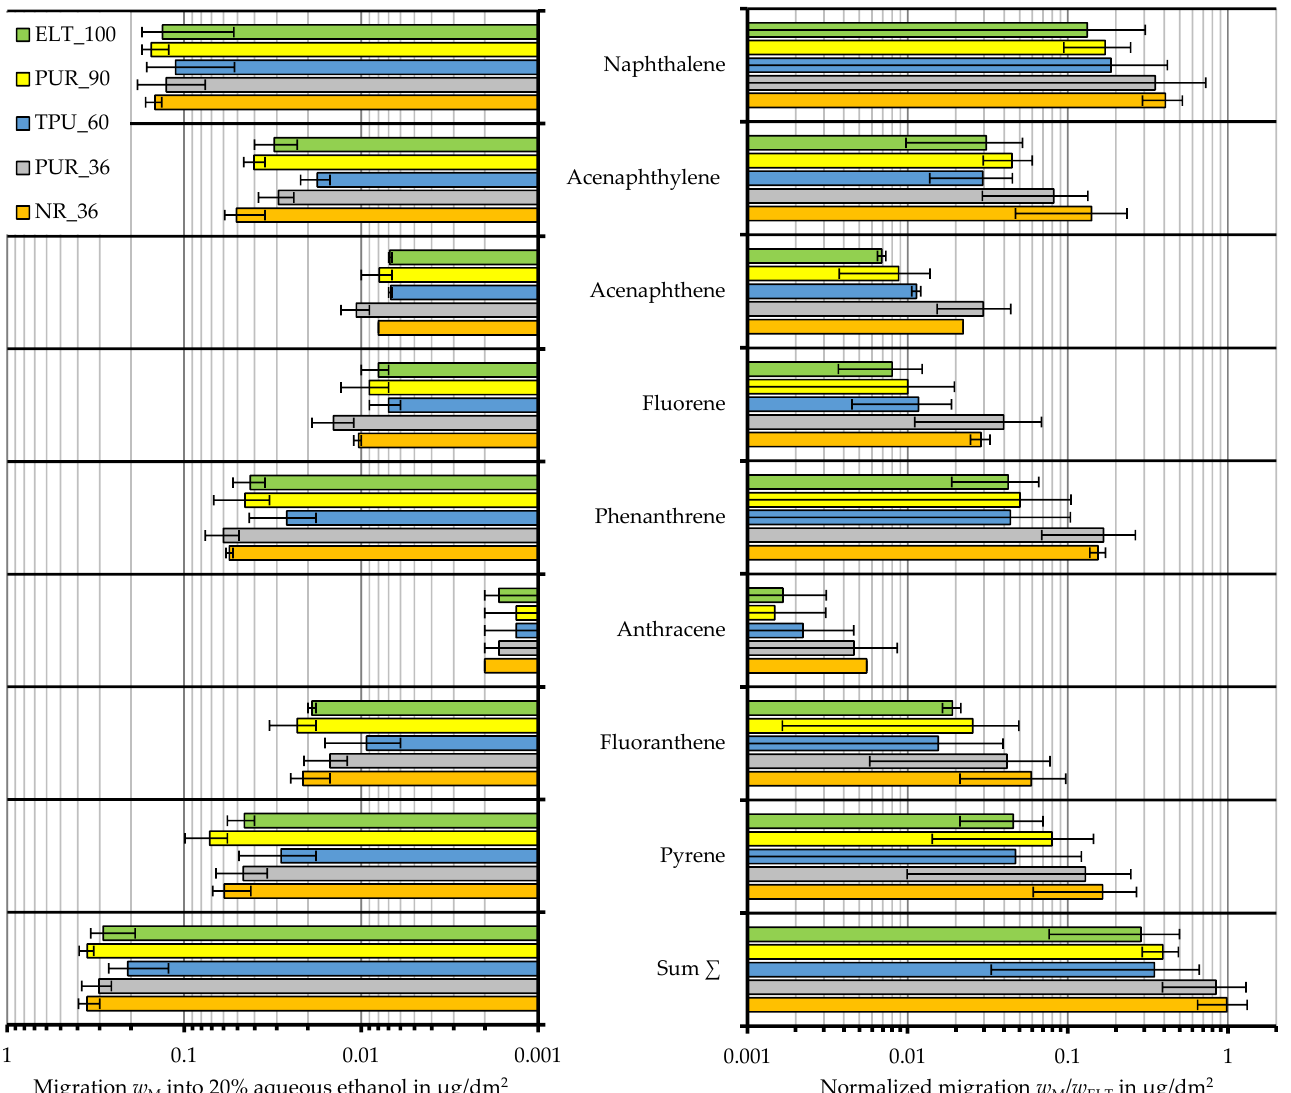
Figure 2. Results (average, min, max) for the specific migration w M of PAH into 20% aqueous ethanol µg/dm 2 ( left ). Normalized results (average and confidence interval for α = 0.05) for w M / w ELT obtained by dividing the results for w M by the respective ELT content w ELT of the samples ( right ).